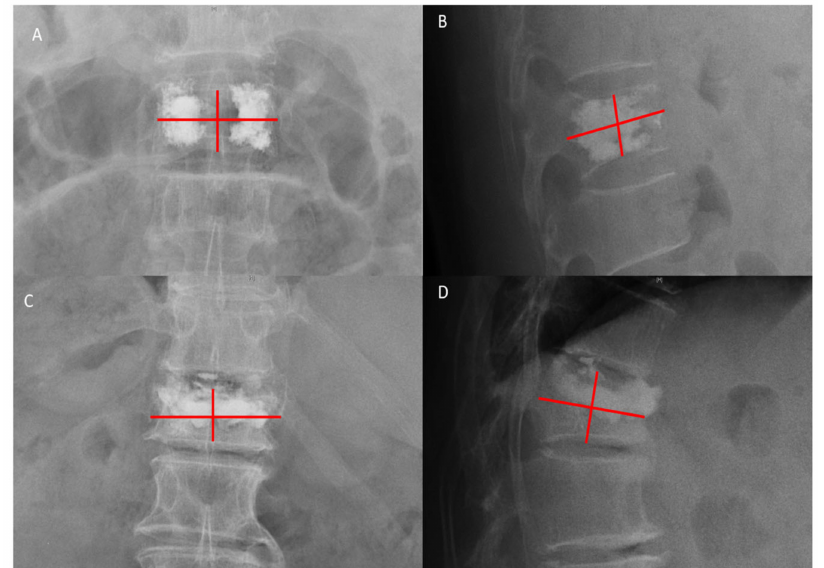
Figure 5. ( A , B ) A 74-year-old male patient with OVCF at T12. Anteroposterior and lateral images were taken after PKP, and the bone cement distribution score was calculated as 4 + 4 + 2 = 10. ( C , D ) A 77-year-old female patient with OVCF at T12. The bone cement distribution score was calculated as 2 + 2 + 1 =